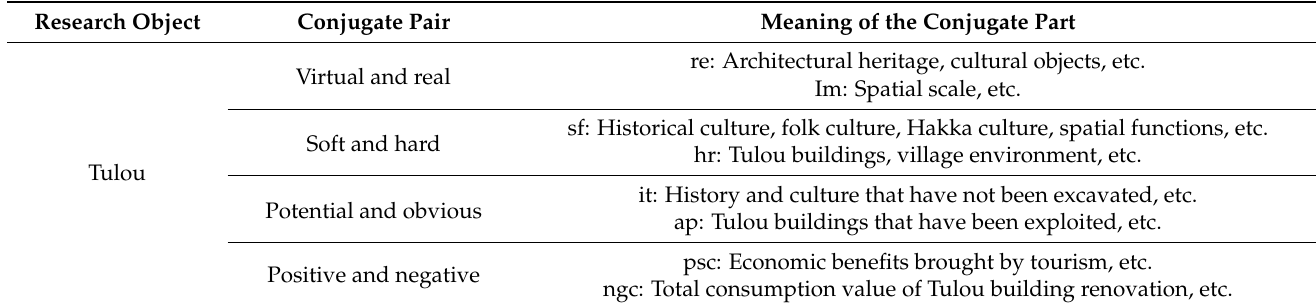
Table 2. The conjugate pair analysis of a